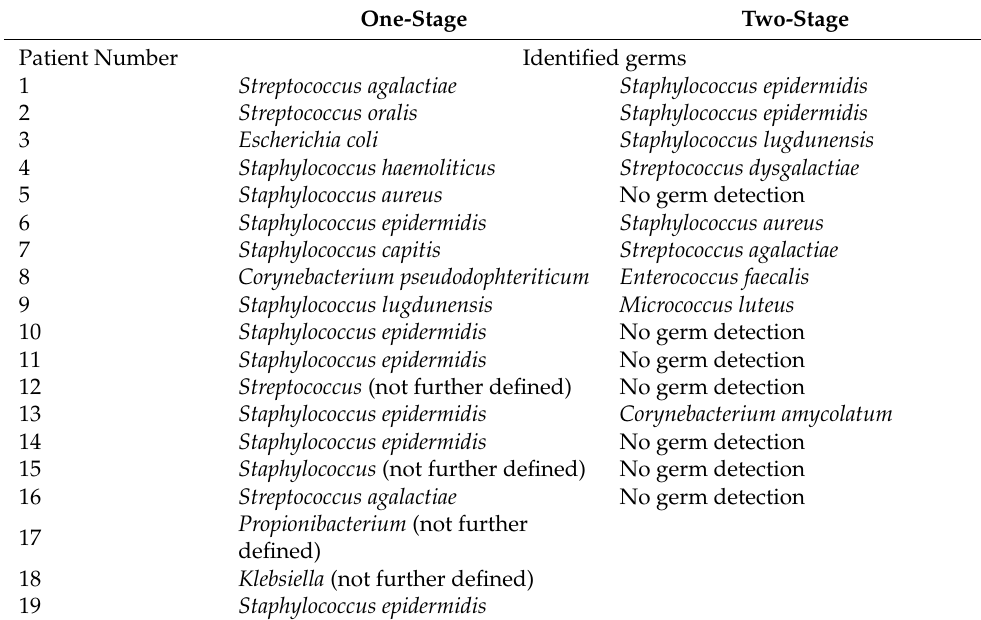
Table 3. Identified germs (one-stage vs. two-stage).